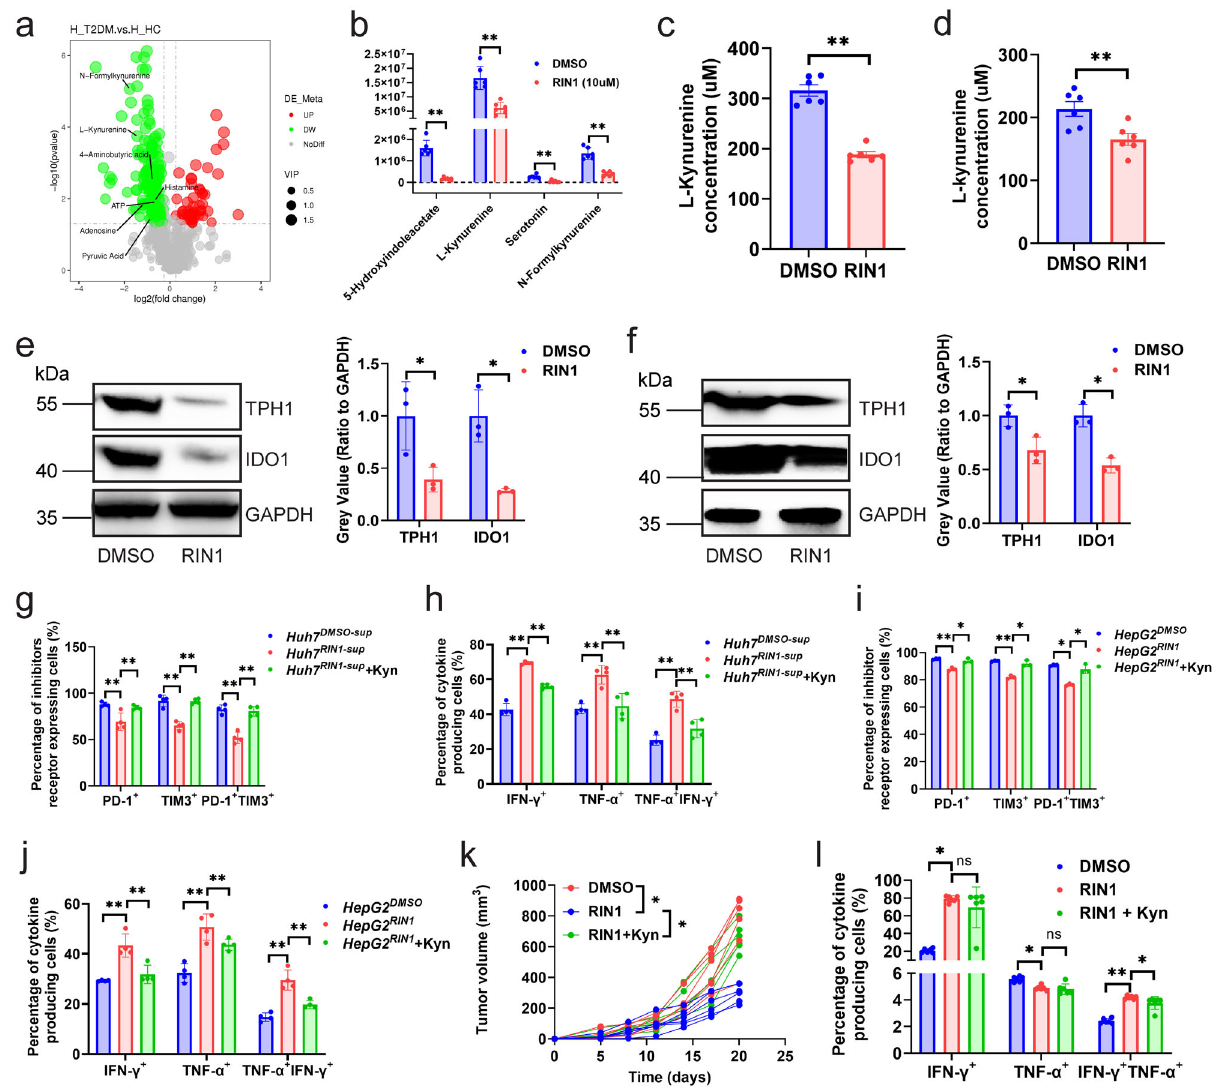
Fig. 5 RIN1 improved CD8 + T cell function by inhibiting tryptophan metabolism. a Volcano plot of metabolome from Huh7 cells treated with DMSO and RIN1 (10 μ M) ( n = 3). Metabolites that were elevated in RIN1-treated cells ( P adj < 0.05 and log2(fold change) > 1) were marked in red, while decreased ( P adj < 0.05 and log2(fold change) < − 1) were marked in blue. Selected metabolites were labeled. b Boxplots demonstrating the abundance of L- kynurenine, N-formylkynurenine, 4-aminobutyric acid, and serotonin in Huh7 cells ( n = 6). c , d ELISA analysis of L-kynurenine secretion by Huh7 ( c ) and HepG2 ( d ) cells ( n = 6). e , f Immunoblot showing the protein expression of TPH-1 and IDO1 in Huh7 ( e ) and HepG2 ( f ) cells ( n = 3). g - j Inhibitory receptor ( g , i ) and cytokine ( h , j ) expression on patient HCC in fi ltrating CD8 + T cells from control, HCC RIN1-sup , and HCC RIN1-sup with L-kynurenine (200 nM) groups, HCC RIN1-sup included Huh7 RIN1-sup ( g , h ) and HepG2 RIN1-sup ( i , j ) ( n = 4). k , l Tumor growth curves ( k ) and cytokine expression on CD8 + T cells in tumors ( l ) from control, intraperitoneal injection of RIN1 (50 mg/kg), and intraperitoneal injection of RIN1 with L-kynurenine (30 mg/kg) groups ( n = 6). Mean ±